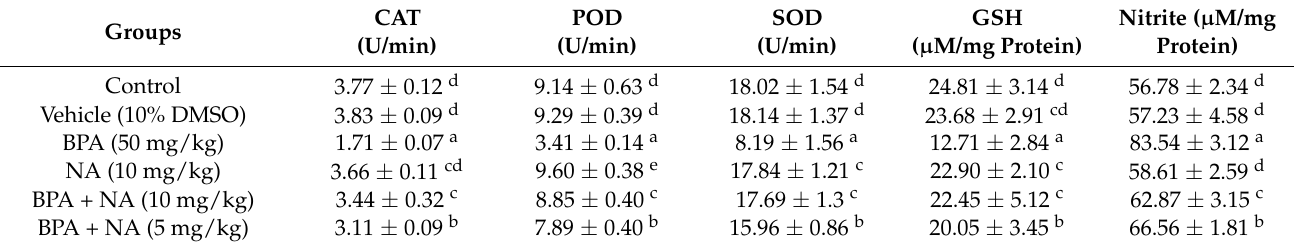
Table 5. Effect of NA on biochemical